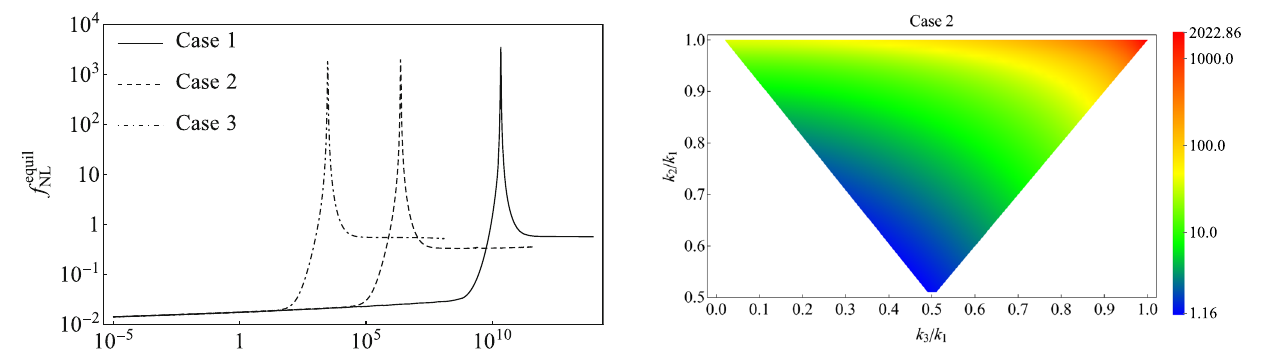
Fig. 7 The non-Gaussianity in the general form of scalene triangle configuration for Case 2 for the three NL